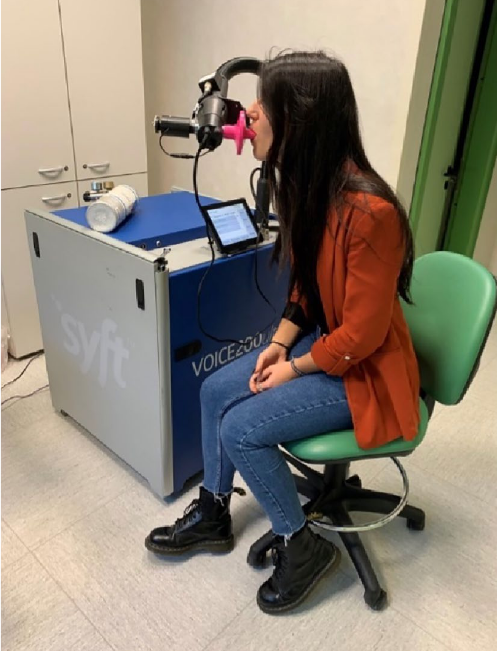
Figure 3. VOCs sample collection of the exhaled air with SIFT-MS technique.